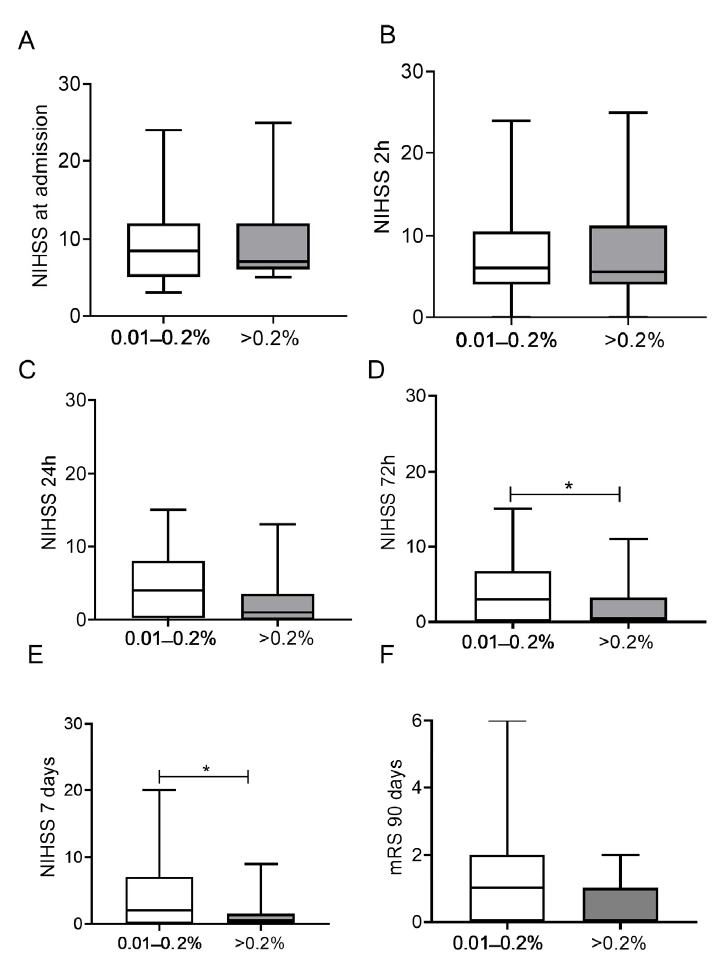
Figure 2. Stroke severity (NIHSS) on admission ( A ), at 2 h ( B ), at 24 h ( C ), at 72 h ( D ), at 7 days ( E ) and mRS at 90 days ( F ) in the alcohol subgroups of below and above 0.2% baseline blood alcohol concentration. NIHSS: National Institutes of Health Stroke Scale, mRS: modified Rankin Scale * p < 0.05.